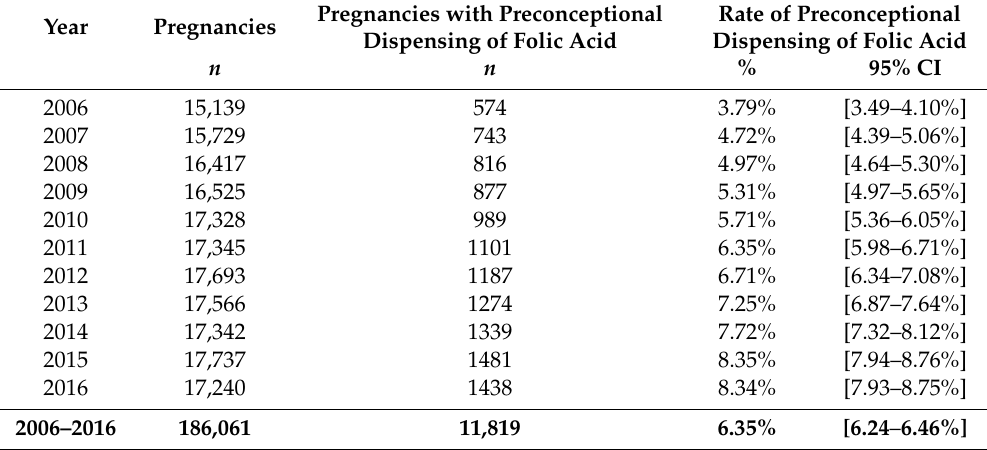
Table 2. Number of pregnancies and rate of dispensing of folic acid in the preconceptional period, between 2006 and 2016 in